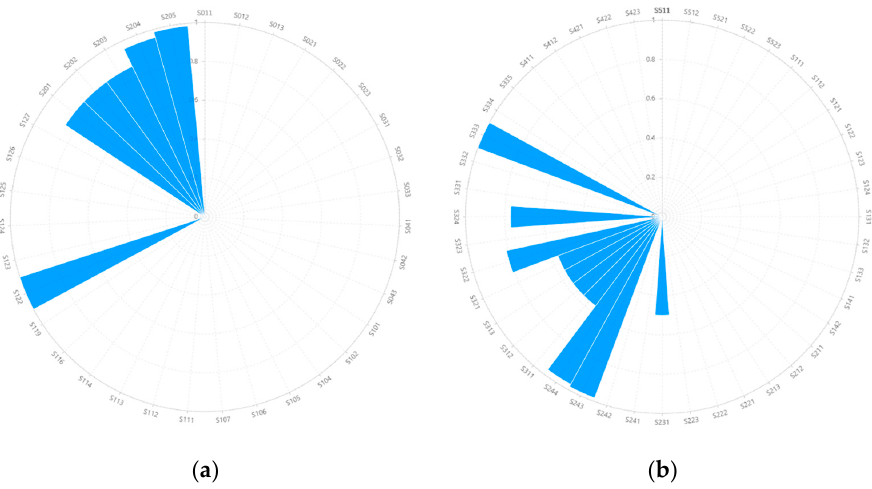
Figure 6. Normalized semantic translation uncertainty results ( a ) from NLS to PWSCS, and ( b ) from CLC to GlobeLand30.